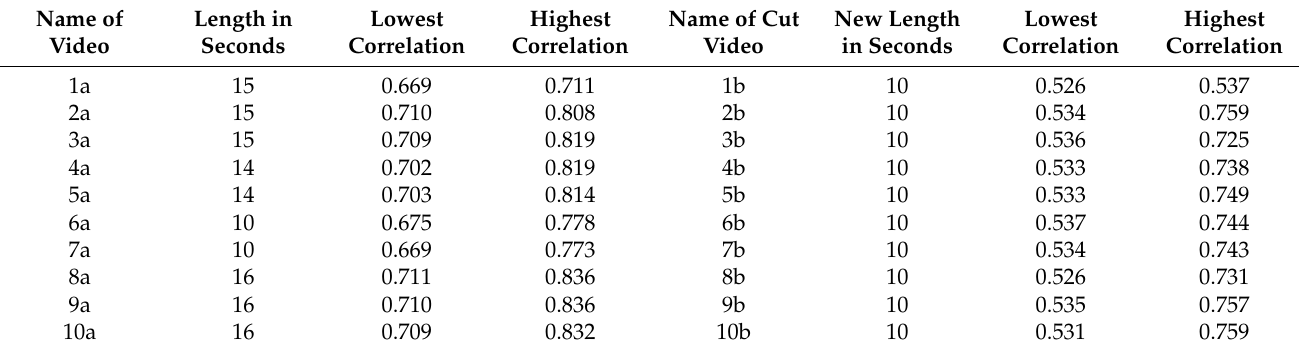
Table 4. Results of the mutual comparisons of both videos with different lengths and videos with the same length (10 s). Name of